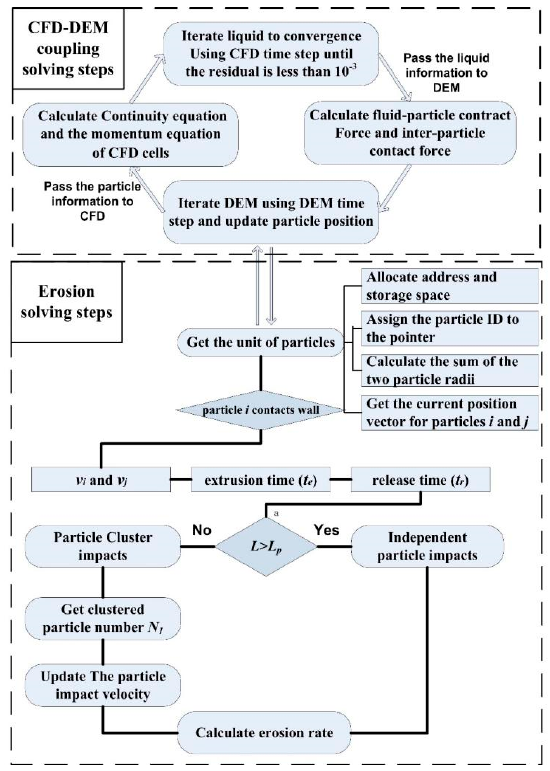
Figure 3. The erosion simulation scheme.